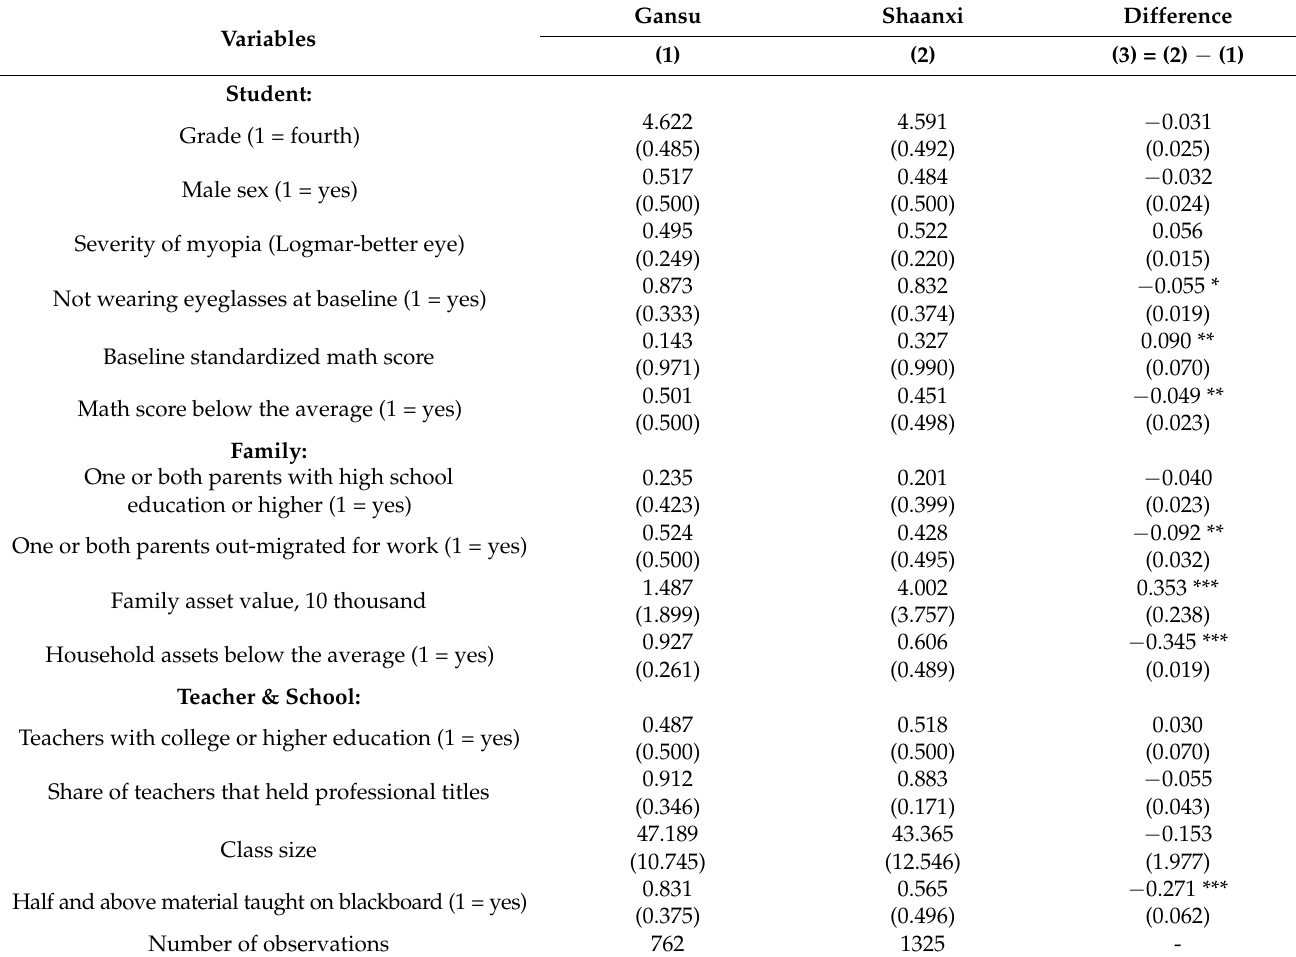
Table 6. Comparison of characteristics at baseline, by